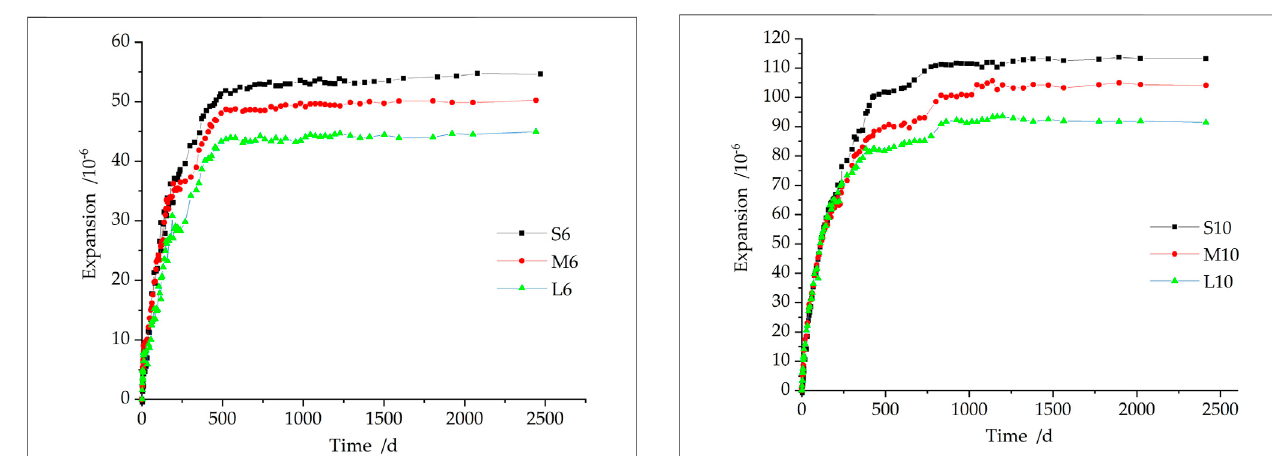
FIGURE 3 | Autogenous volume deformation of long-aged concrete mixed with 6% MgO at different specimen sizes.